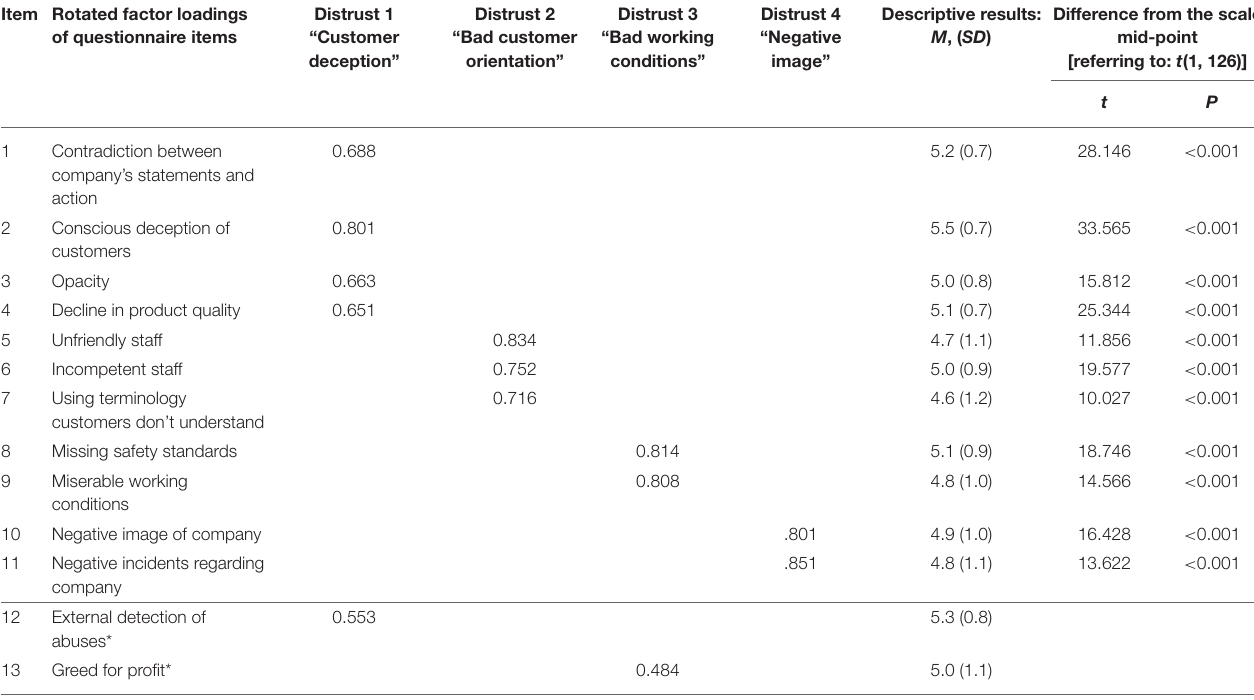
TABLE 4 | Results of distrust items: PCA and descriptive statistical results (items with factor loadings < 0.6 were excluded, marked in the table with an asterisk). Item Rotated factor loadings of questionnaire